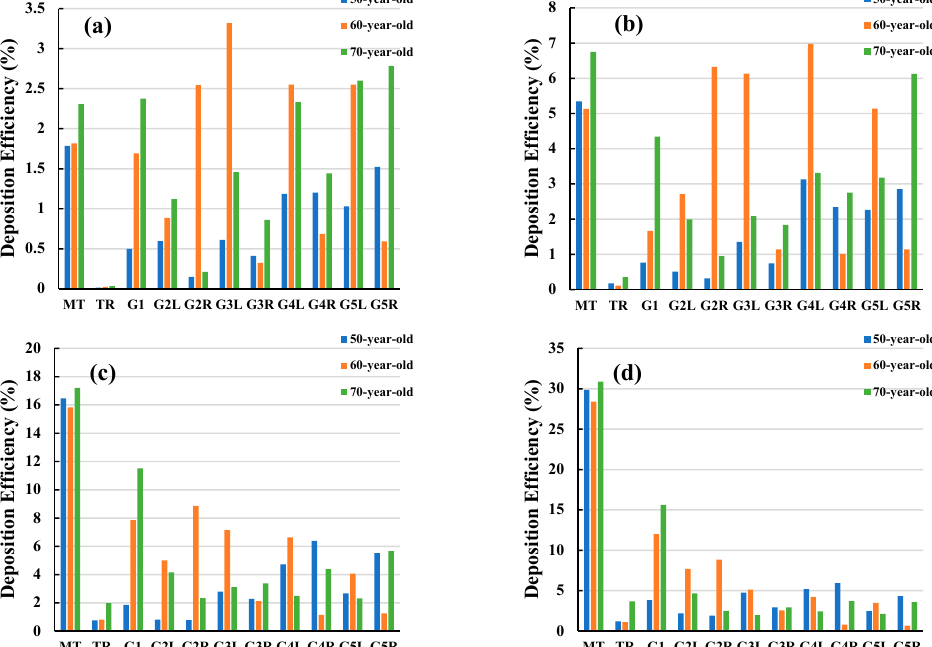
Figure 10. Polydisperse particle DE at various airway positions for different flow rates, ( a ) 7.5 L/min, ( b ) 15 L/min, ( c ) 30 L/min, and ( d ) 60 L/min. MT, mouth-throat; TR, trachea; G1, Generation 1; G2L, Generation 2-left lung; G2R, Generation 2-right lung; G3L, Generation 3-left lung; G3R, Generation 3-right lung; G4L, Generation 4-left lung; G4R, Generation 4-right lung; G5L, Generation 5-left lung; and G5R, Generation 5-right lung.